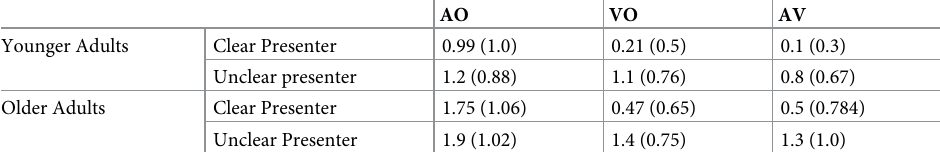
Table 3. Mean number (Standard deviation) of other non-target (competitor) emotions selected as a function of presentation modality, presenter, and age